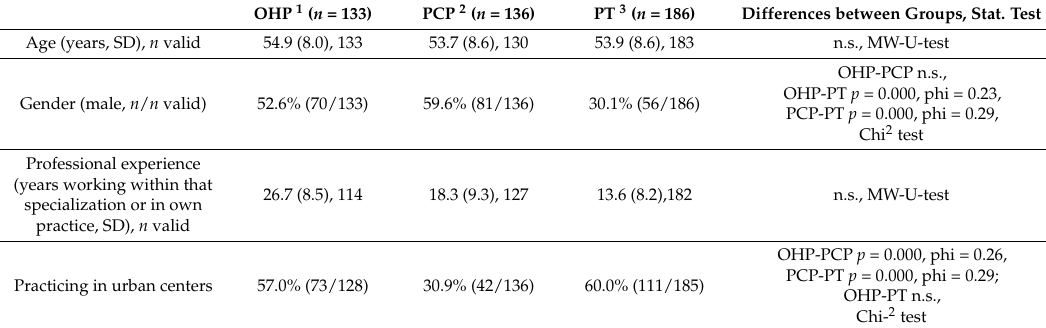
Table 1. Sample characteristics.